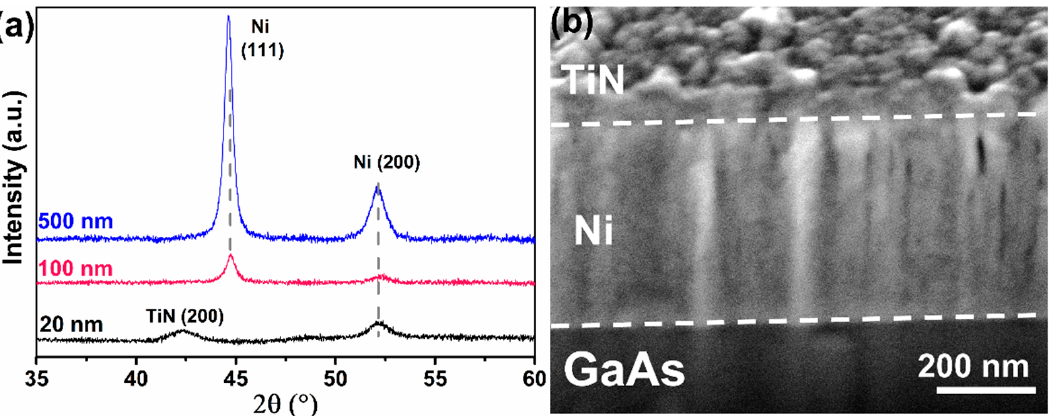
Figure 1. ( a ) Ex situ XRD diagrams for the as deposited Ni/GaAs samples with different Ni layer thicknesses (20 nm, 100 nm, and 500 nm) and ( b ) cross-section SEM image of the as-deposited 500 nm-thick